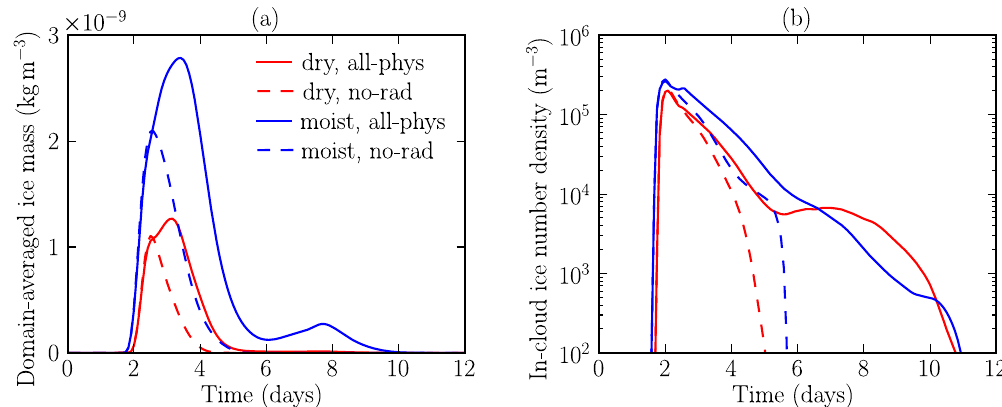
Figure 1. Evolution of (a) the domain-averaged ice mass and (b) the ice number density averaged over the cloudy area in the no-rad and all-phys simulations for both the dry and moist